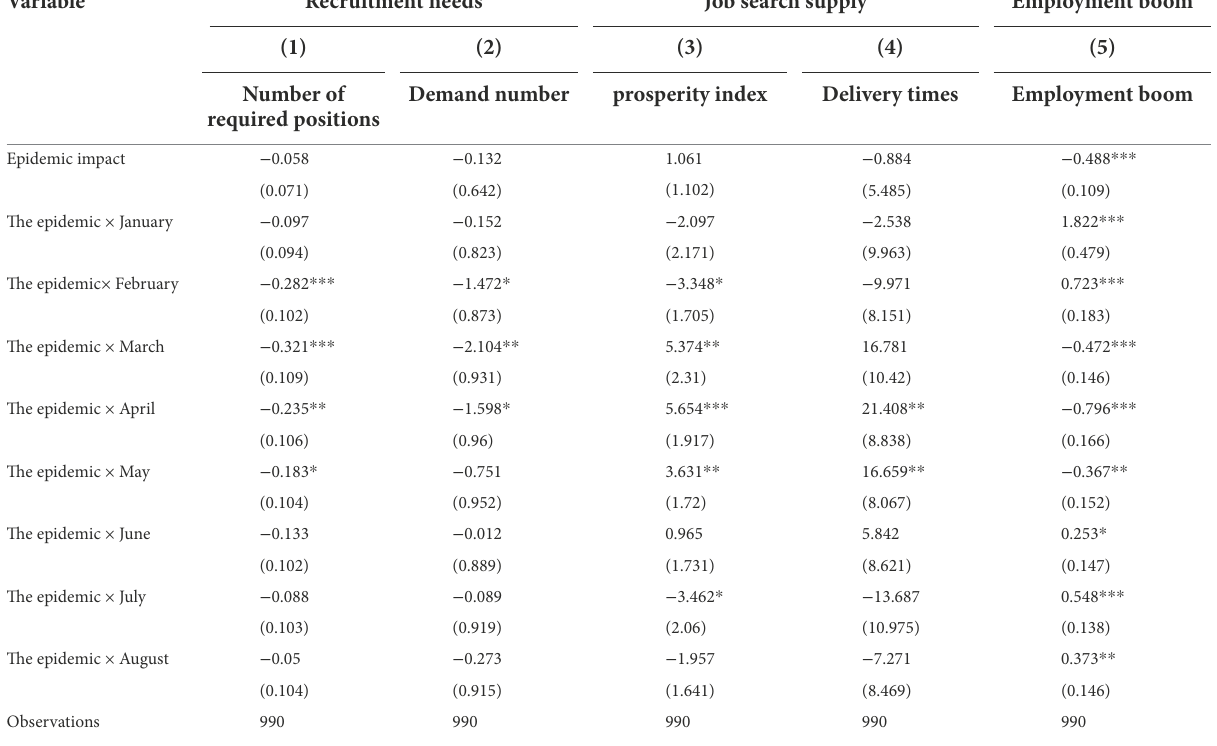
TABLE 3 Time trend effect of